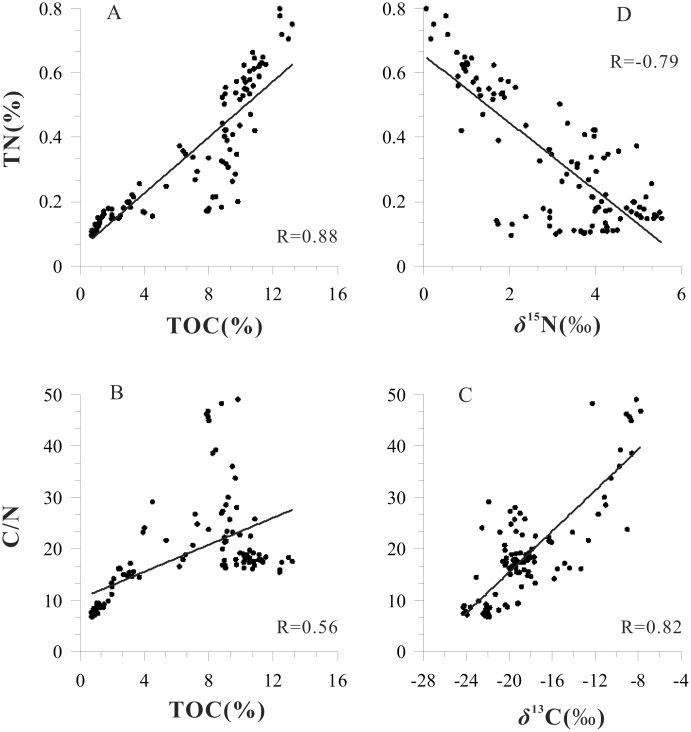
Correlations between TOC contents, TN contents, C/N ratios, δ13C and δ15N (n = 108).The correlations were all highly significant (P<0.01).